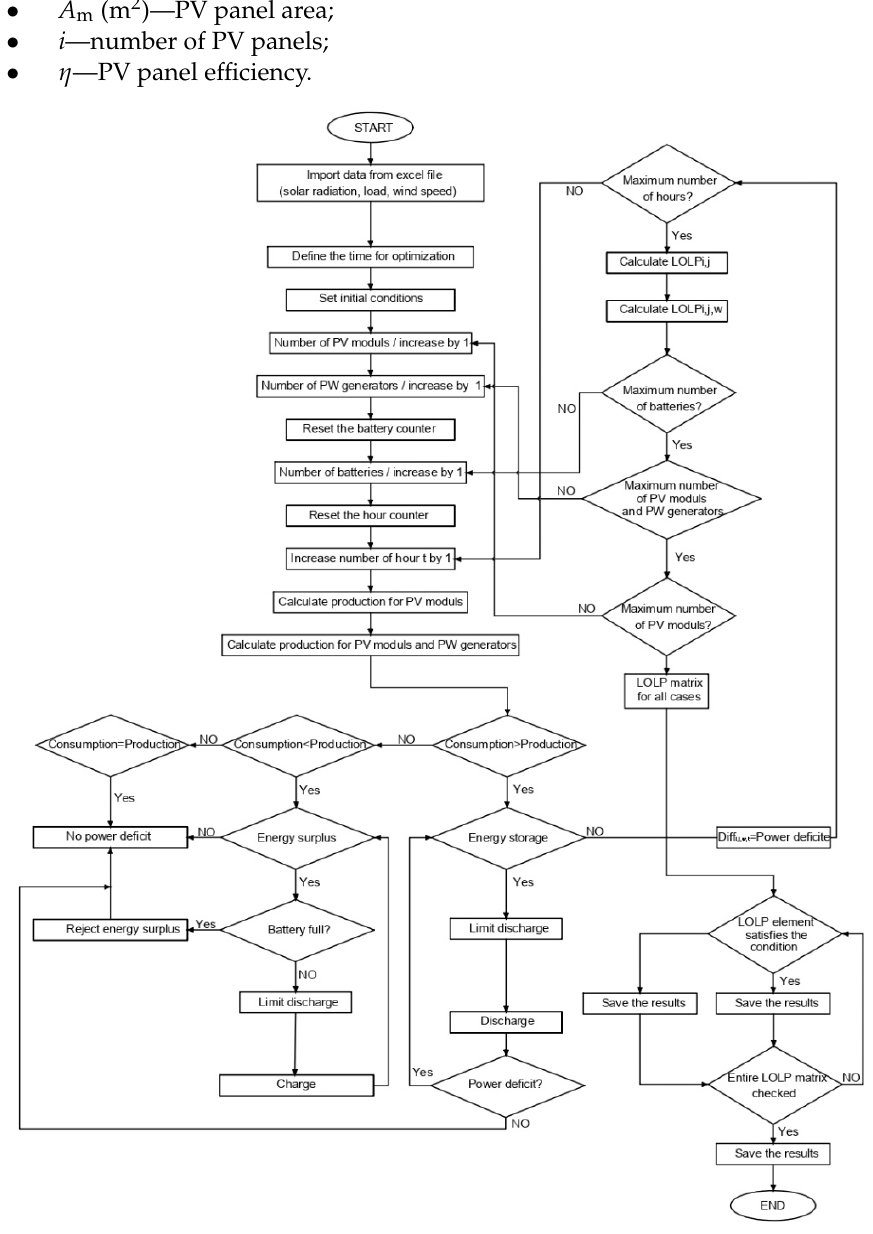
Figure 1. Structural diagram of simplified model .